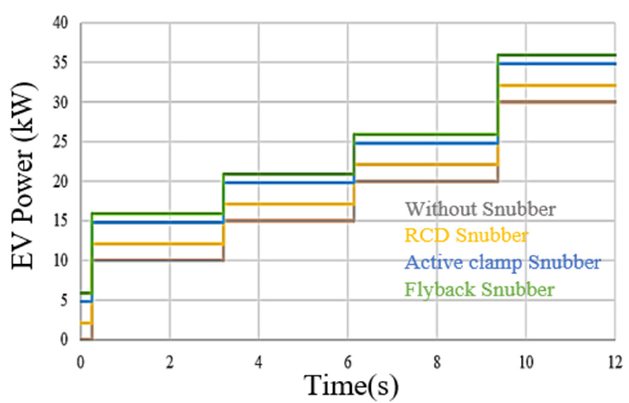
Figure 8. Power response curve of EVs.